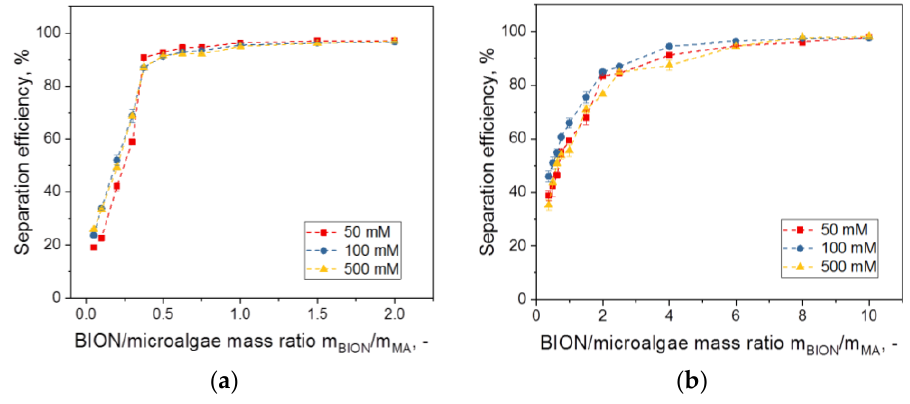
Figure 5. Separation efficiency of S. ovalternus ( a ) and C. vulgaris ( b ) at pH 4 and for different NaCl concentrations in the respectively relevant nanoparticle-to-microalgae mass ratio.